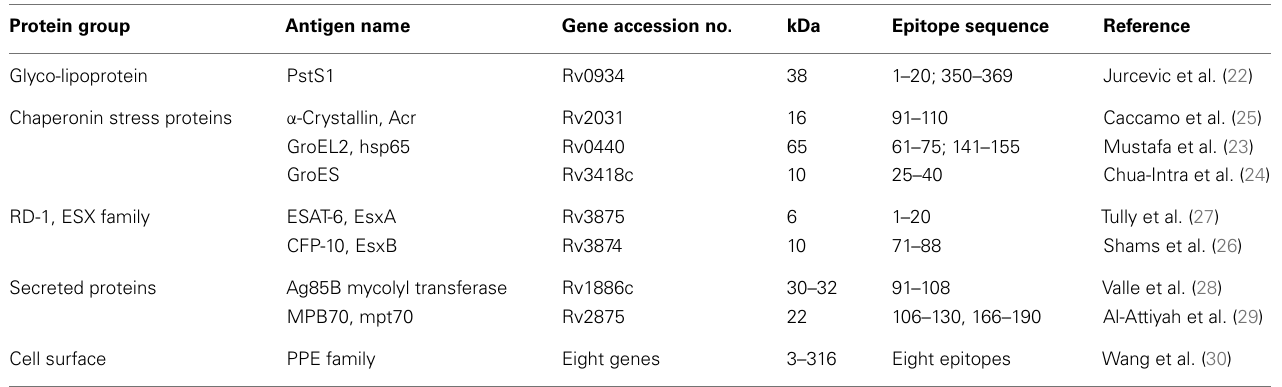
Table 1 | Mtb antigens with identified HLA-DR-permissive CD4 + T-cell stimulatory